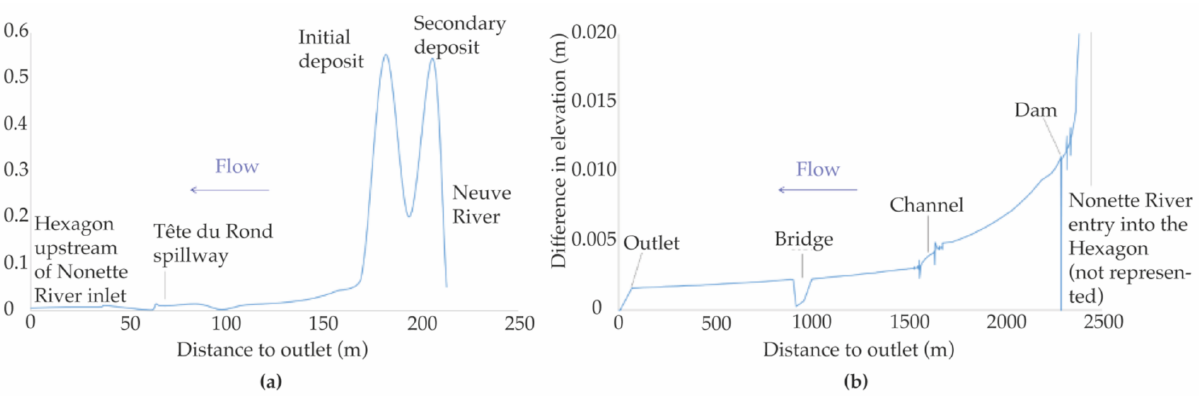
Figure 15. Calculated longitudinal profile of the deposition height at the end of 2001–2010 decade. ( a ) Upstream of the GC; ( b ) downstream of the